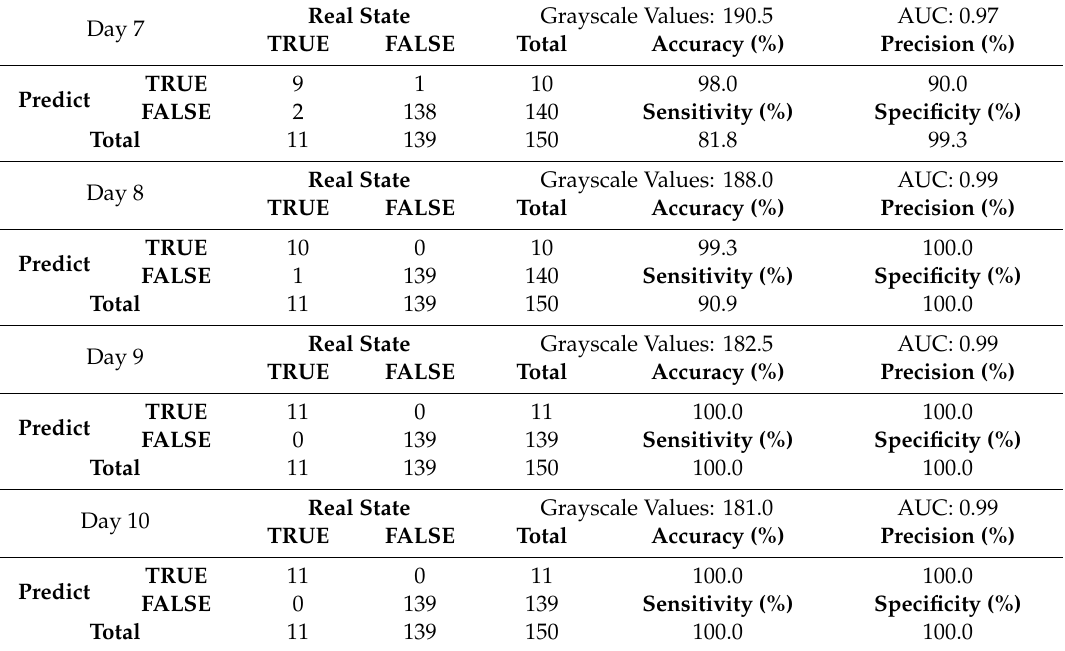
Table 3. Using detection device to identify and classify unfertilized eggs on the 7th–10th day.